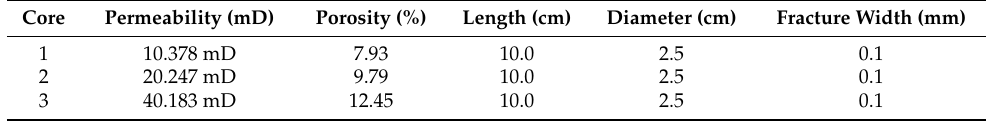
Table 4. Physical parameters of the artificial cores.